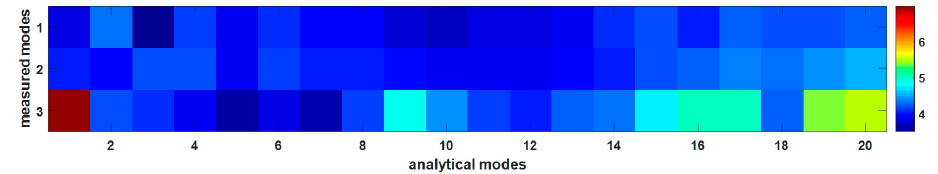
Figure 4. The sensitivity index of damage case A versus MCs N i = 20 and N j = 3, at a 3% level of noise.